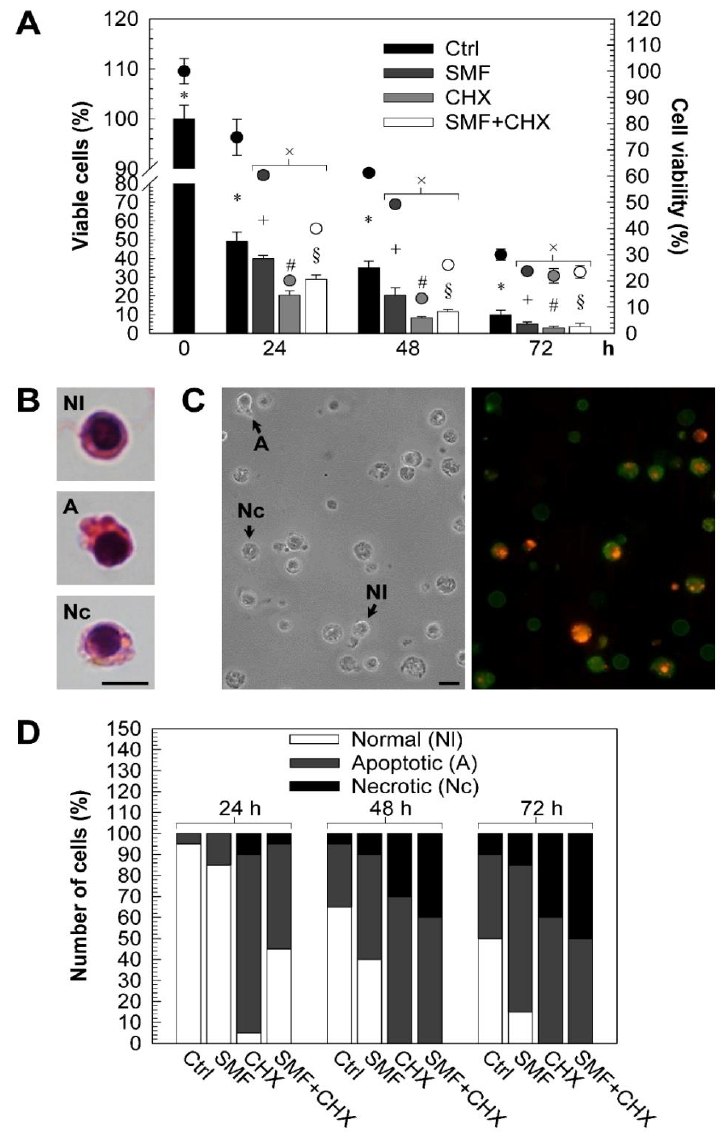
Figure 1. Cell viability. ( A ): Percentage of viable peripheral blood lymphocytes (PBLs) following the different treatments by trypan blue dye exclusion assay (histograms) or MTT assay (dots). All values referred to the value of control PBLs at 0 h, taken as 100%. Each error bar represents the SE of